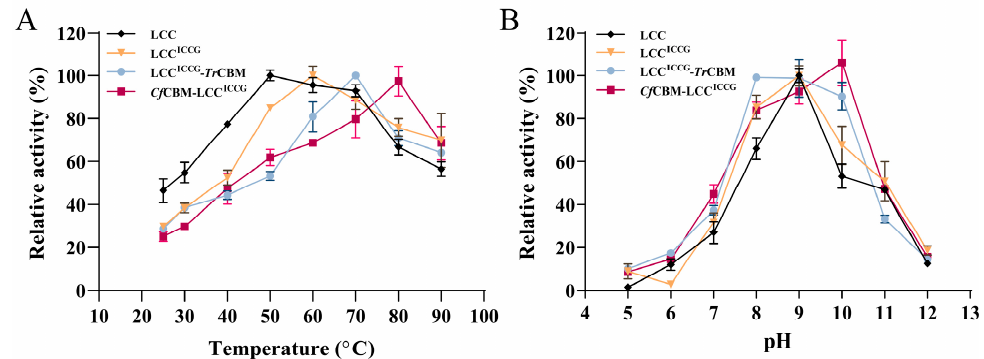
Figure 3. The optimal temperature ( A ) and pH ( B ) of LCC, LCC ICCG , LCC ICCG - Tr CBM and Cf CBM- LCC ICCG , using the hydrolysis of p -NPC as a model. The highest activity was considered as 100%, and relative activities were calculated accordingly. Data were presented as mean value ± SD of triplicate experiments.